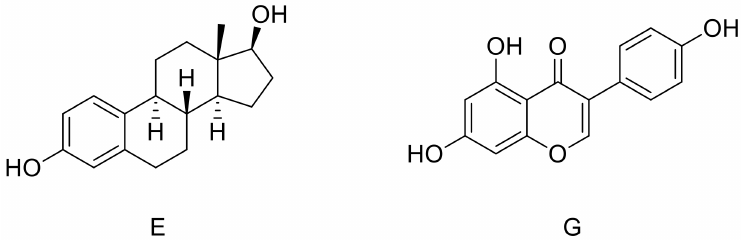
Figure 1. Structures of 17 β -estradiol ( E ) and genistein (G)